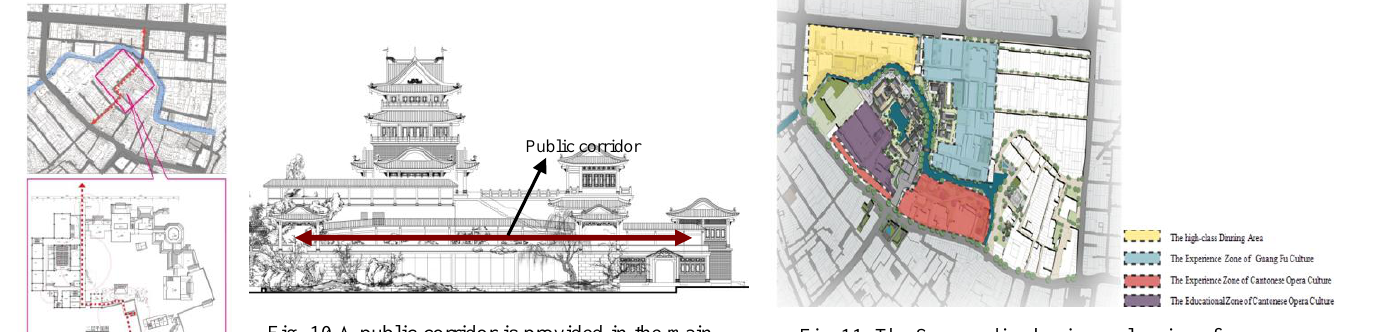
Fig. 11: The Surrounding business planning of the Cantonese Opera Art